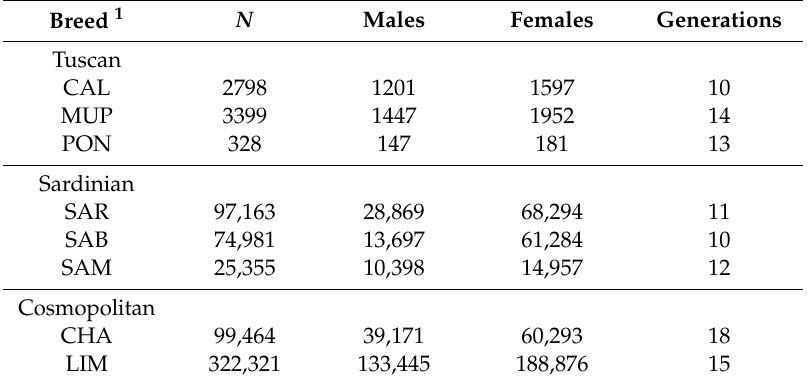
Table 1. Number of pedigree records ( N ), number of males, females, and generations for each breed. Breed 1